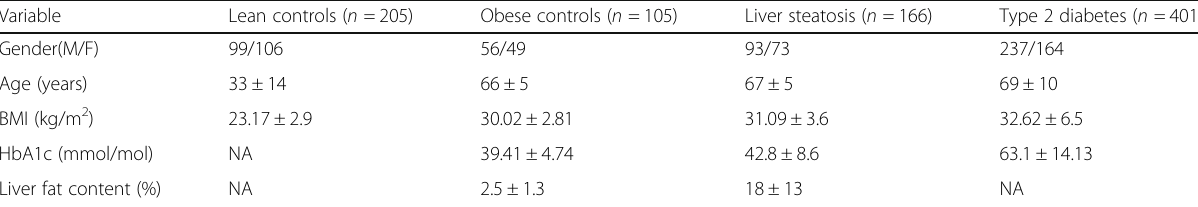
Table 1 Characteristics of our 4 groups of patients and controls